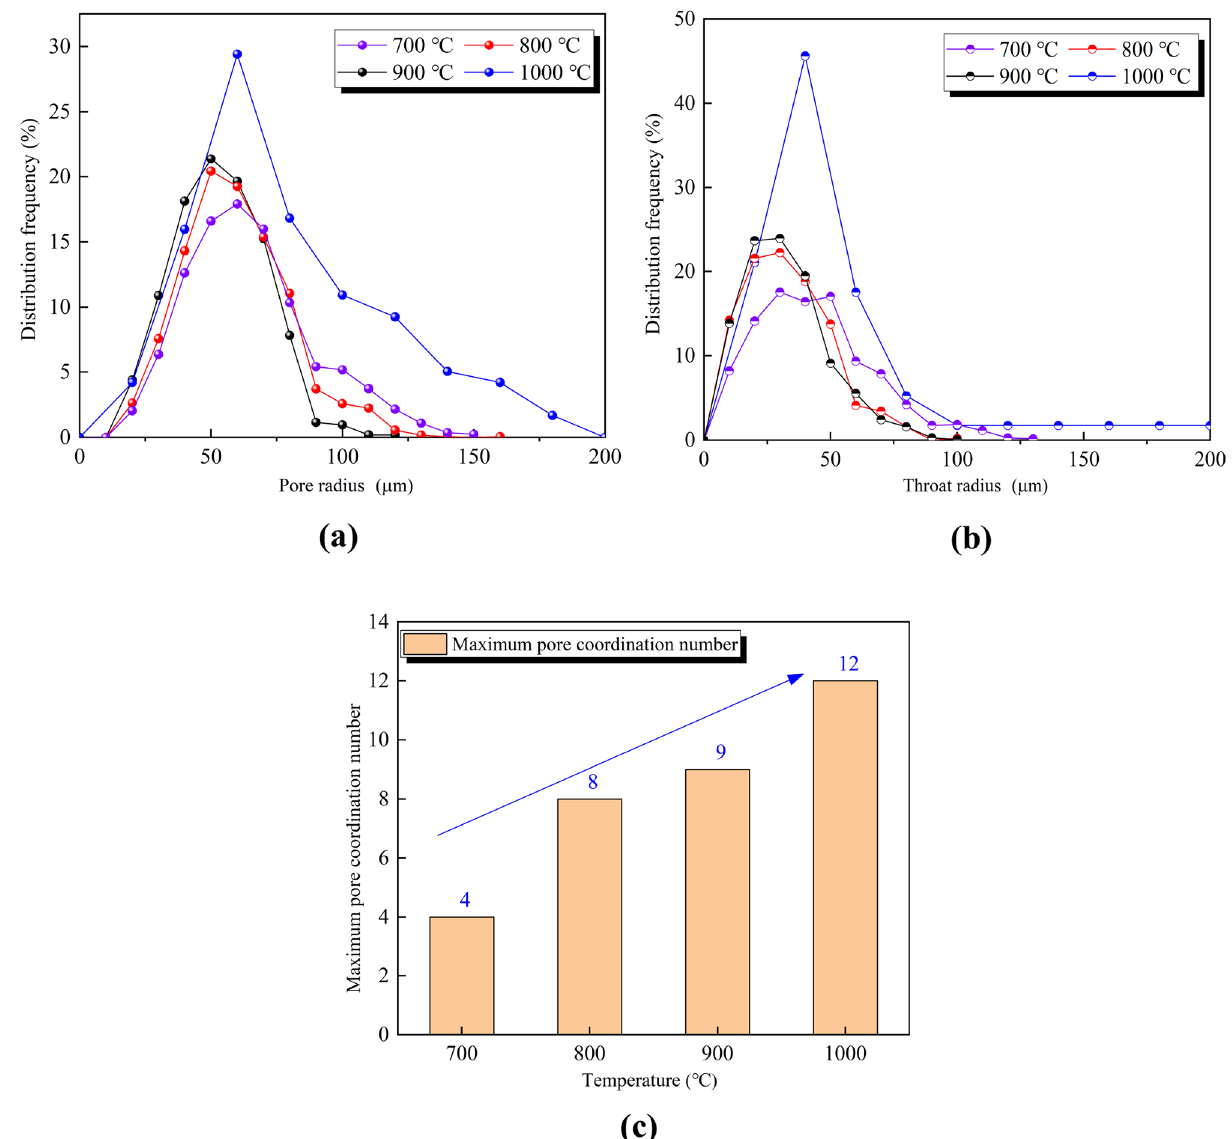
Figure 11. Frequency of pore characteristics distributions of limestone samples after high-temperature treatment: ( a ) Distribution of pore radius; ( b ) Distribution of throat radius; ( c ) Distribution of maximum pore coordination